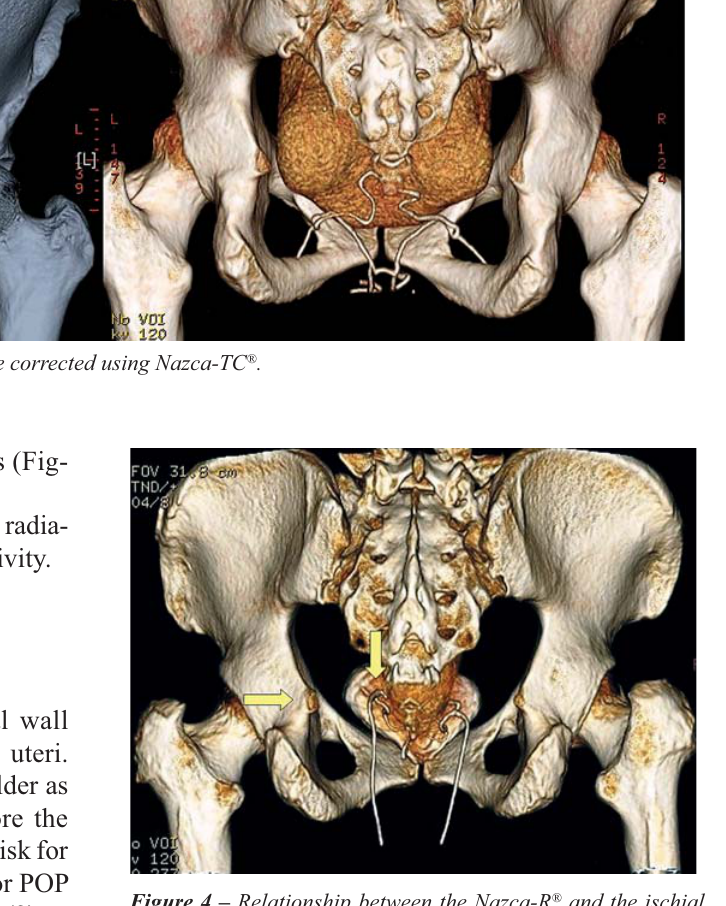
Figure 4 – Relationship between the Nazca-R ® and the ischial spine.